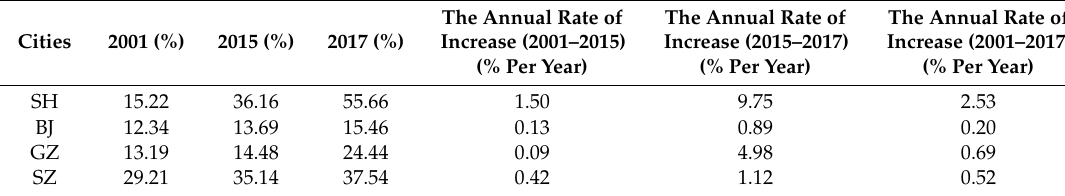
Table 6. Changes of impervious surface area in the study areas.